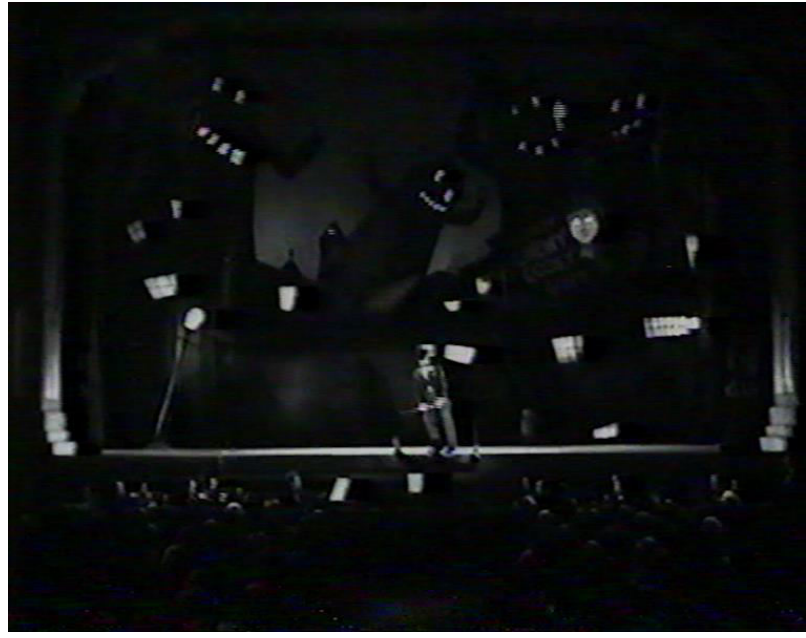
Figure 5. “Puttin’ on the Ritz” reaches its climax as the leering anthropomorphic buildings start to